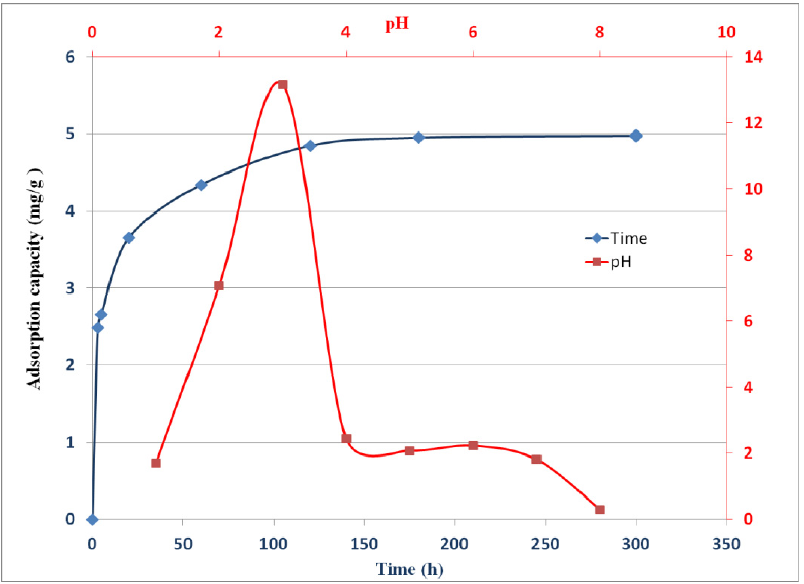
Figure 7. Effect of pH (red) and contact time (blue) on chromium adsorption onto